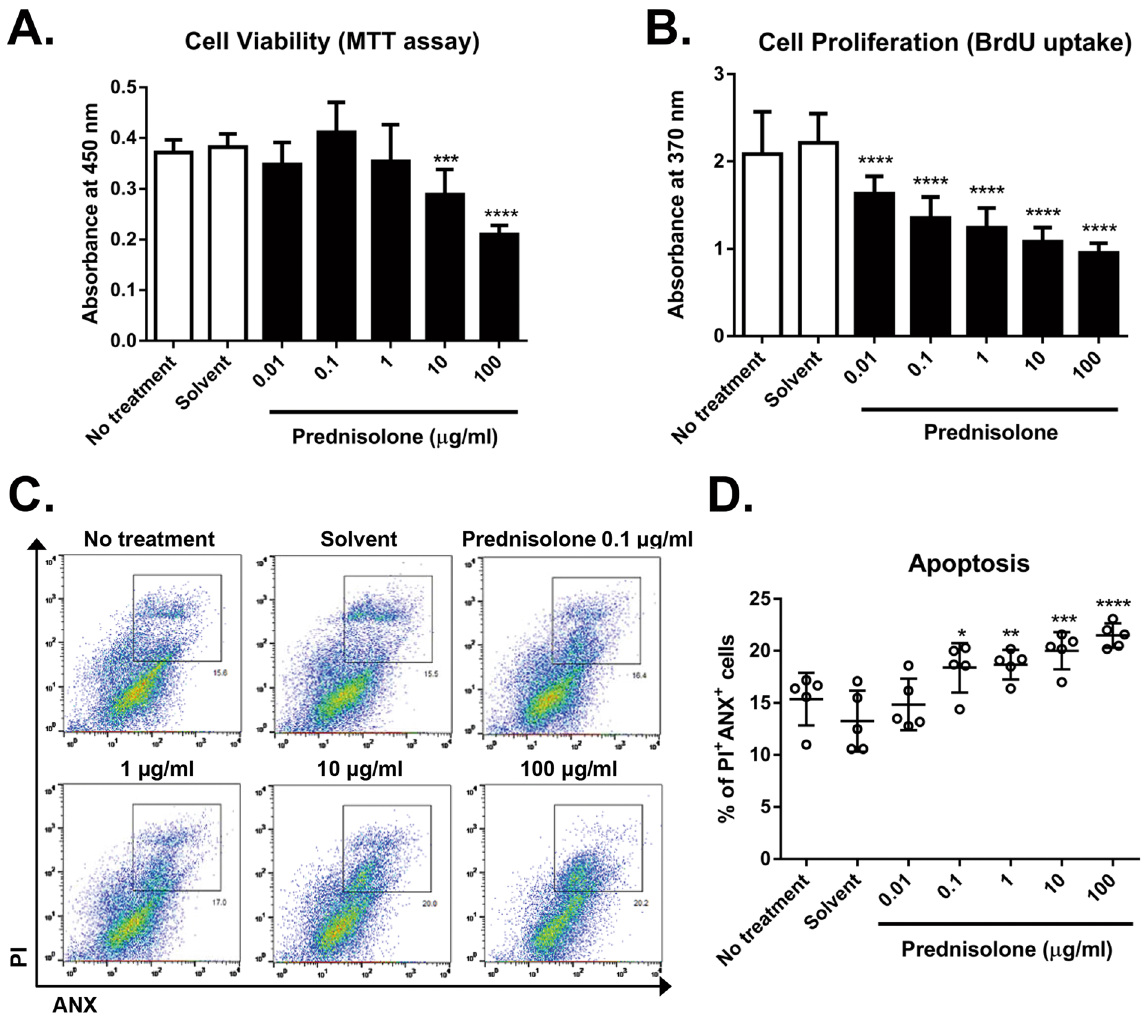
Figure 1. Effects of prednisolone on metabolic activity, proliferation, and apoptosis in human corneal epithelial cells (hCECs). hCECs were cultured in the presence of various concentrations of prednisolone for 3 days and subjected to assays. The cells without any treatment or with solvent treatment alone served as controls. ( A ) MTT assay to measure cell metabolic activity. ( B ) BrdU uptake assay to measure cell proliferation. ( C ) Representative flow cytometry plots for Annexin V (ANX) + and propidium iodide (PI) + cells, indicative of apoptotic cells. ( D ) Quantitative flow cytometry results for ANX + PI + cells. Data are presented as mean ± / + SD from five independent sets of experiments including at least five samples per a set. * p < 0.05, ** p < 0.01, *** p < 0.001, **** p <